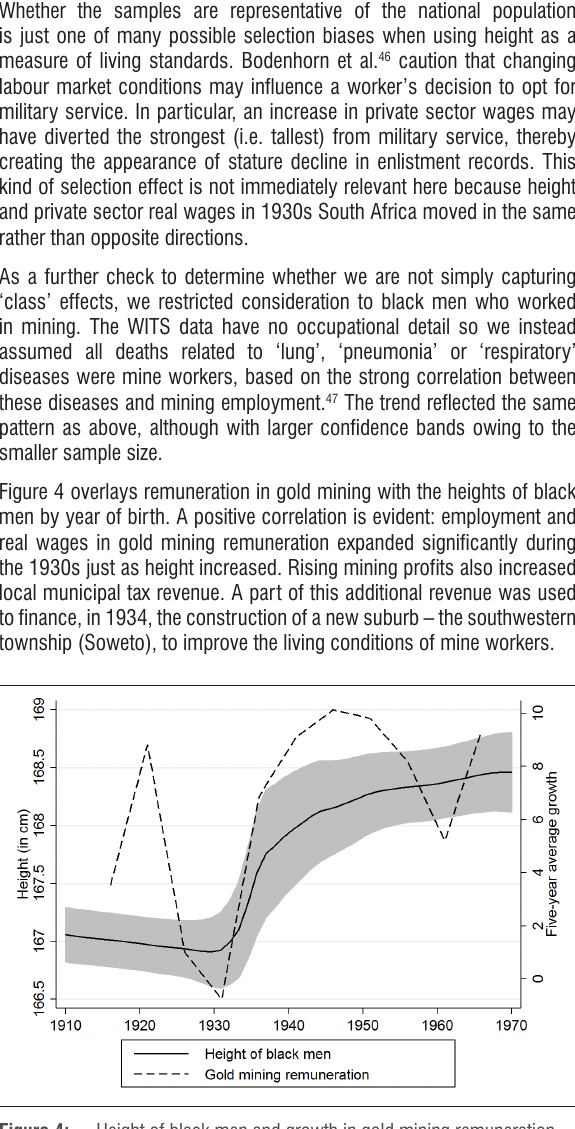
Figure 2: Height of black men by year of birth, 1895–1990, from four data sources.